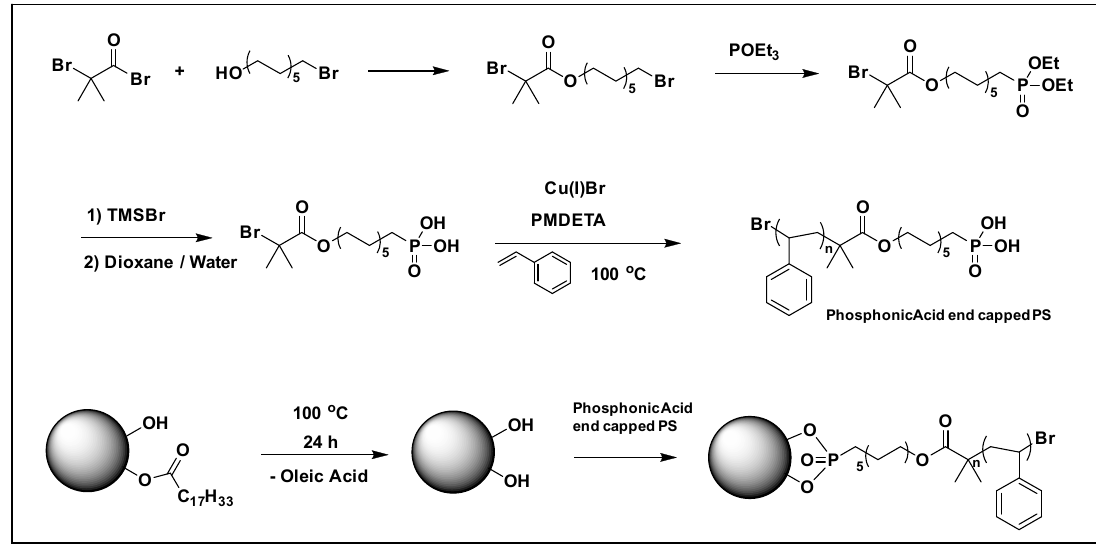
Figure 17. Synthesis of phosphonate end capped polystyrene and ligand exchange reaction of diethyl phosphonate end capped polystyrene with oleic acid terminated TiO 2 nanoparticles to generate polystyrene coated TiO 2 (PS@TiO 2 ) Reproduced with permission from Ref. [220].